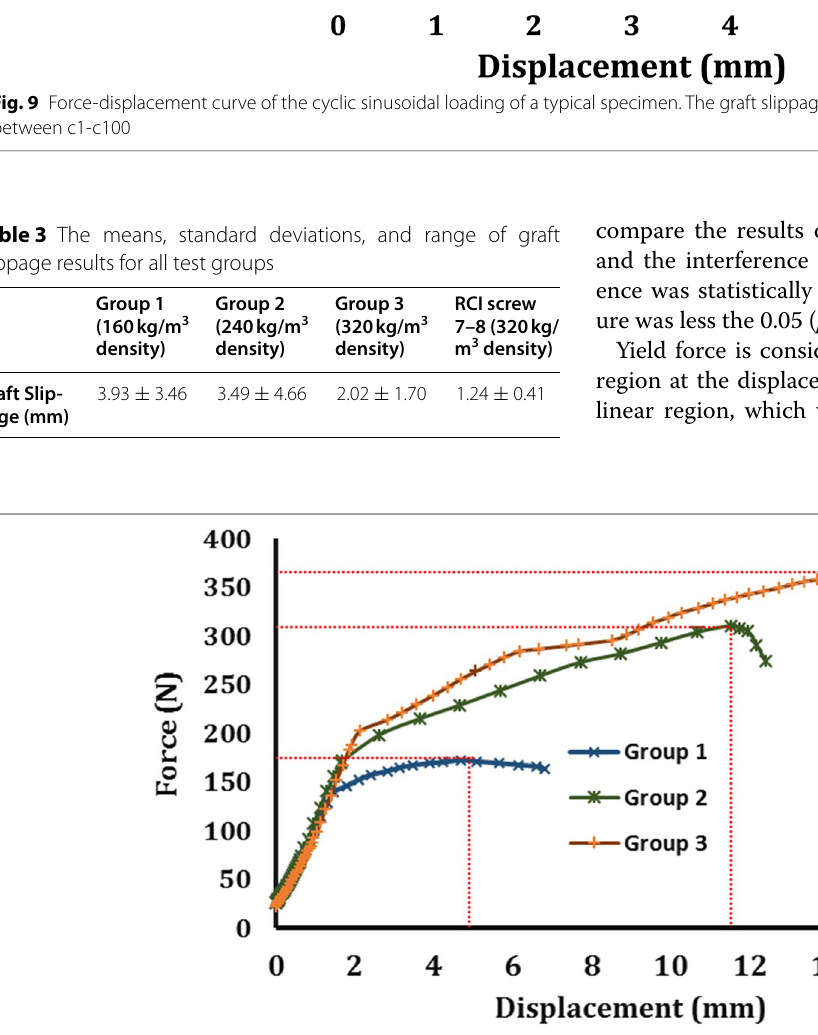
Fig. 10 The averaged load-displacement curves of the three test groups during the failure loading tests. The ultimate strengths are shown in the